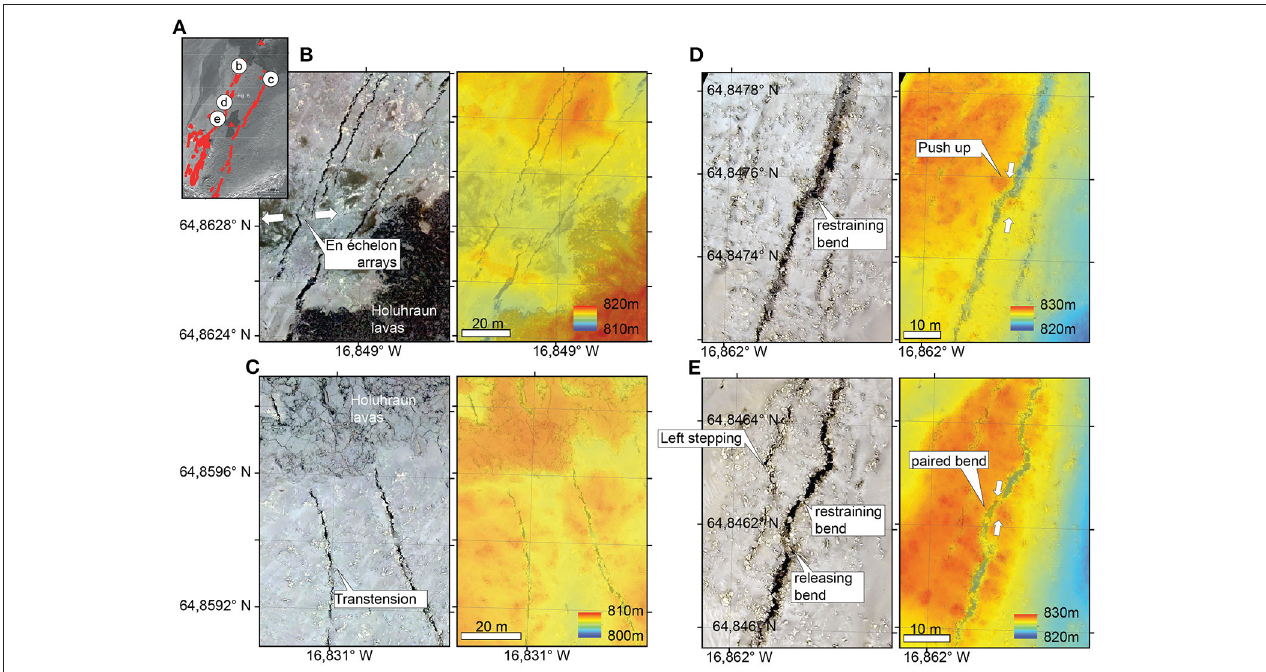
FIGURE 5 | Local structural examples– (A) Fracture overview map together with close-up view locations as shown in insets b-e (SfM photo mosaic and SfM DEM model). Red triangles show the 2014 Holuhraun and 5 September 2014 eruption sites. (B) Photo mosaic showing en echelon arrays of surface fractures commonly associated with strike-slip kinematics. The DEM shows no dominant vertical throw and the observed fractures mainly opened horizontally. (C) Curved fractures directed to the NNW and partly covered by lavas. Field data and aerophotos suggest a transtensional type of fracturing. (D) Local restraining bends lead to push-up structures that are visible in photo mosaic and DEM. (E) Local bending fracture traces lead to releasing bends and restraining bends as topographic